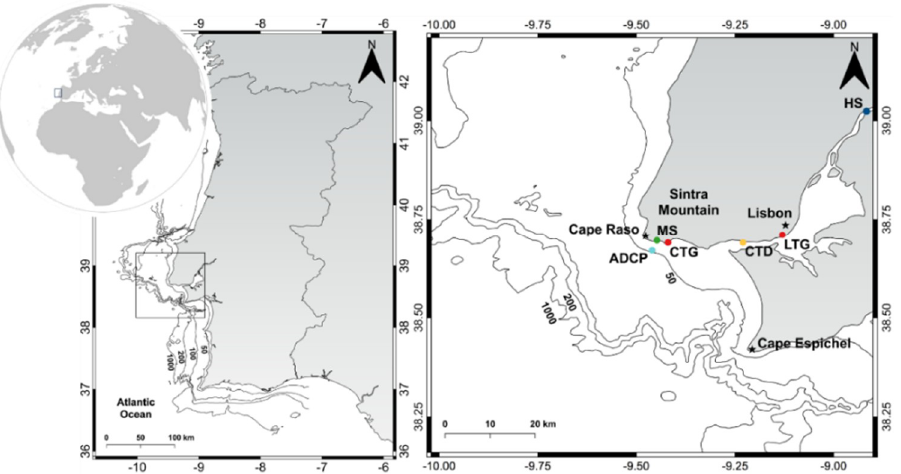
Figure 1. Map of the TagusROFI area showing the sites where environmental parameters were taken. HS–Hydrologic Station; LTG–Lisbon Tide Gauge; CTG–Cascais Tide Gauge; CTD–Conductivity, Temperature, and Depth probe; ADCP–Acoustic Doppler Current Profiler; MS–Meteorological Station.